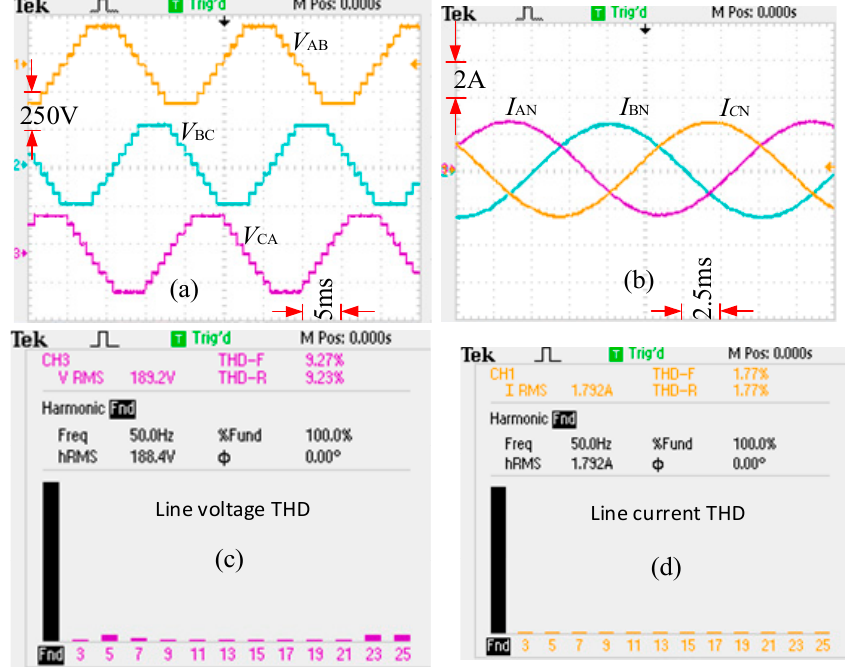
Figure 9. Experimental results, ( a ) line voltages; ( b ) line currents; ( c ) THD of the line voltage; ( d ) THD of the line current, when CHB cells are fed by Symmetric dc power supplies.